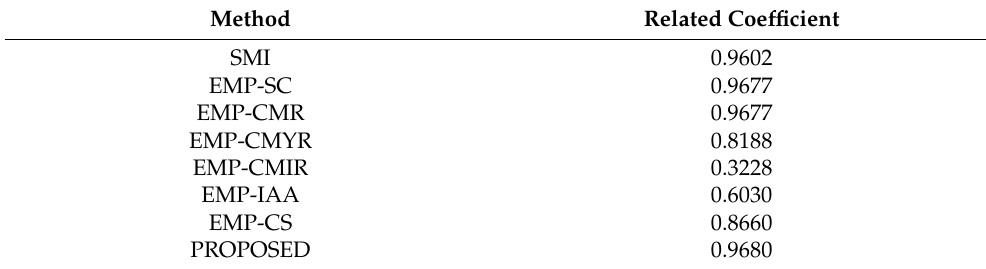
Table 1. Comparison of related coefficients.